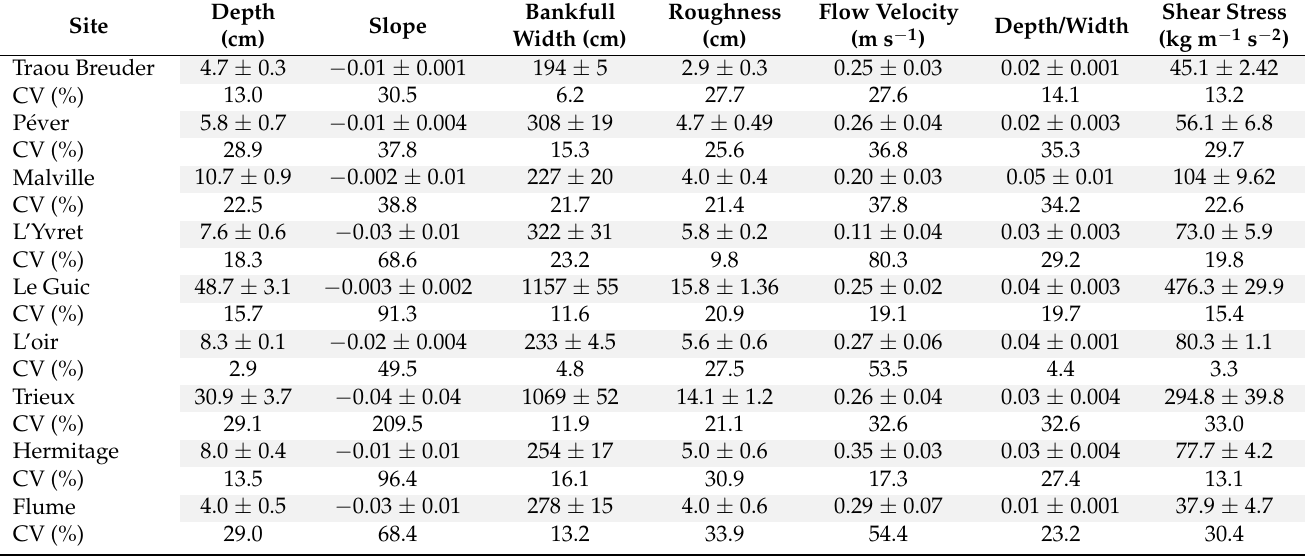
Table 3. Mean values ( ± SE) and coefficient of variation (CV) of morphological